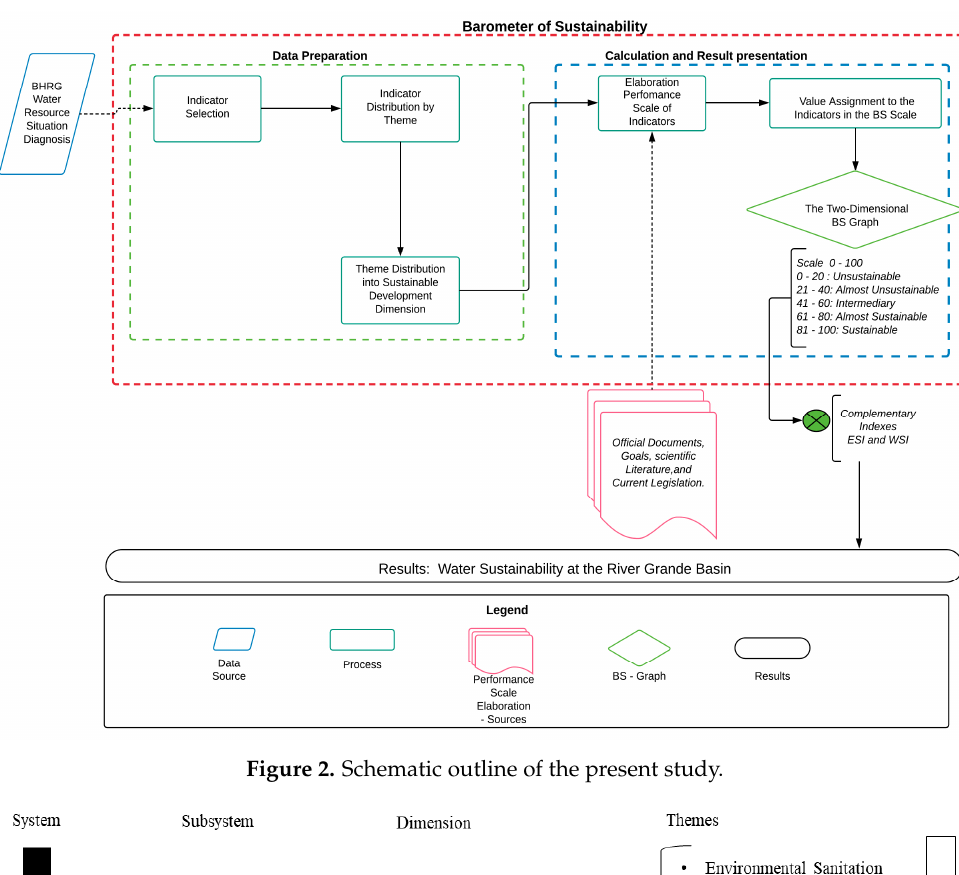
Figure 2. Schematic outline of the present study.